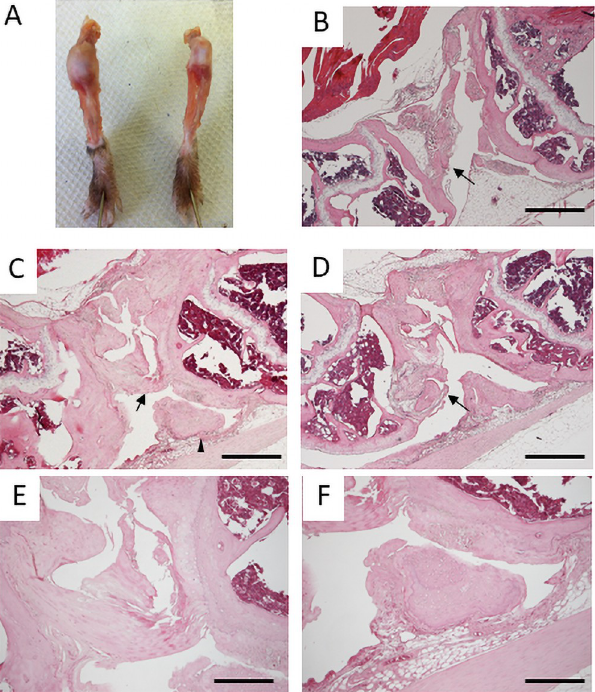
Fig 1. Knee joints of six-month-old mice. A. Gross appearances of knee joint capsules of Prx1-Vcan (left) and Prx1-Vcan +/+ (right). B. Histological Analysis of Prx1-Vcan +/+ knee joint (H&E). Note that the PCL is normal (arrow). C. Prx1-Vcan knee joint (H&E). PCL is disorganized (arrow), and joint mouse is observed (arrowhead). D. Prx1-Vcan knee joint (H&E). A false joint is observed on the distal end of the femur (arrow). E. High power view of the arrowhead region in Panel C (H&E). Note degeneration of the ligament with calcification assessed by the tidemark. F. High power view of the region of the arrowhead in Panel C (H&E). Note the presence of a small free body composed of cartilaginous tissue. Bar = 500 μ m in B-D, 200 μ m in E, F.